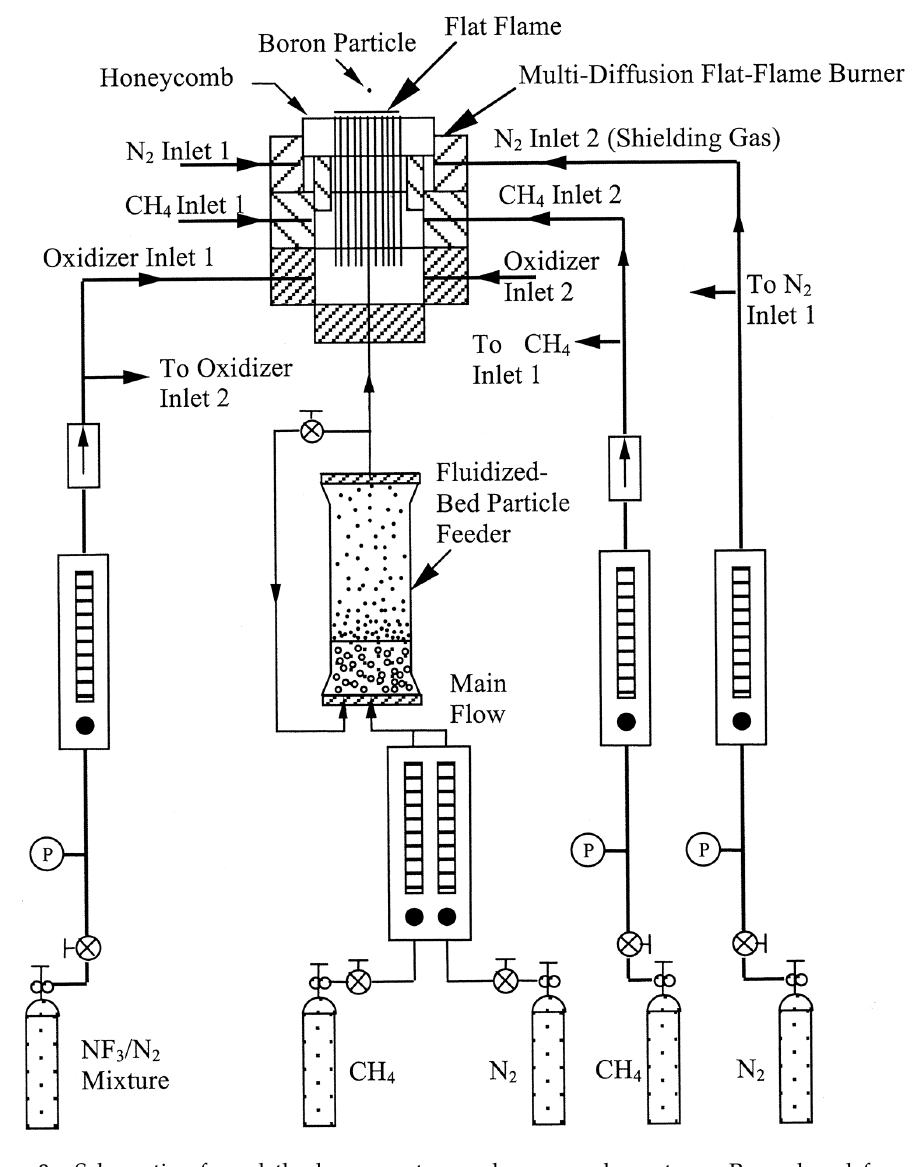
Figure 8. Schematic of used the burner setup and gas supply system. Reproduced from [26], with permission from Elsevier,